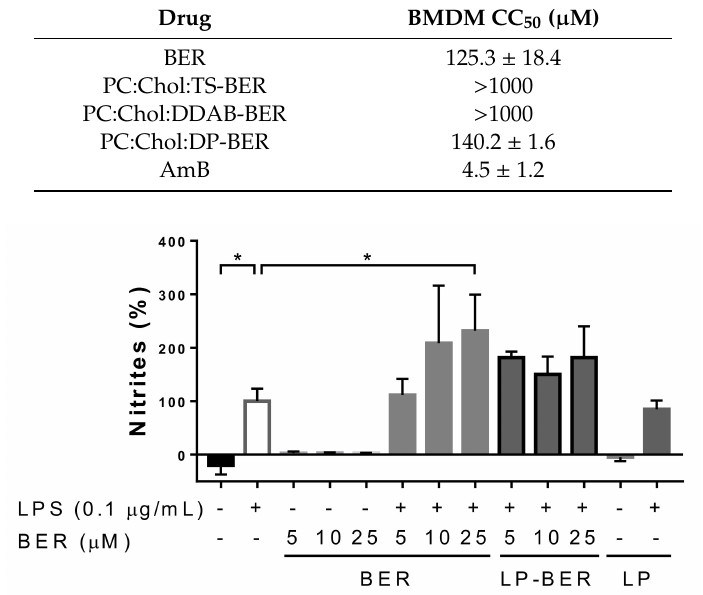
Figure 1. Nitrites production by bone marrow-derived macrophages (BMDM) after 48-h treatment with di ff erent concentrations of free berberine (BER), LP-BER (berberine liposomes) or blank LP (LP, equivalent to 25- µ M BER in BER LP), alone or plus Escherichia coli lipopolysaccharide (LPS) (0.1 µ g / mL). Macrophages stimulated with LPS used as positive control. Results expressed as mean ± SD (n = 5). Data analyzed by one-way ANOVA followed by Dunnett’s multiple comparisons test. * p <